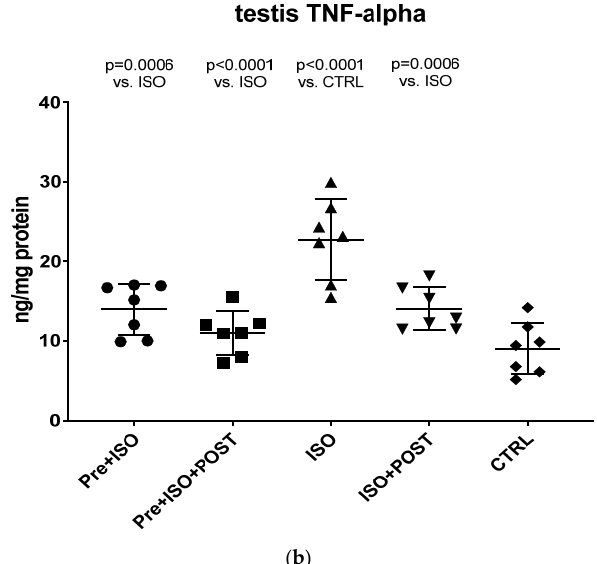
Figure 4. ( a ) The effects of isoproterenol treatment and exercise training on testicular interleukin-6 (IL-6) concentrations, expressed as ng/mg protein. ( b ) The effects of isoproterenol treatment and exercise training on testicular tumor necrosis factor-alpha (TNF- α ) concentrations, expressed as ng/mg protein. The results are shown as mean ± S.D., n = 7/group, one-way ANOVA, Tukey’s post-test. Sig- nificant differences between treatment groups are shown with exact p values. PRE = Pre-swimming, ISO = Isoproterenol injection, POST = Post-swimming, CTRL = Control group, TNF- α = tumor necrosis factor-alpha, IL-6 =